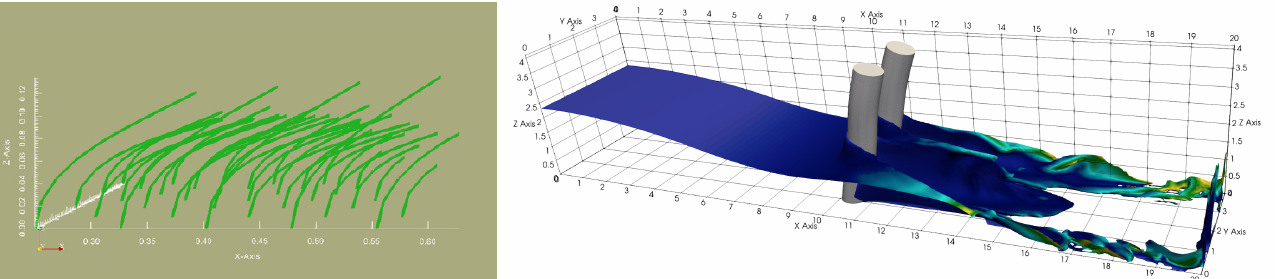
Figure 4. Two examples of flexible vegetation in a three-dimensional flow at large Reynolds number. Left : bent idealized 1D vegetation submerged in a channel flow (adapted from the work in [88]). Right : two-way fluid–structure interaction model of 3D idealized trees in a dam break triggered flow (image courtesy of Abhishek